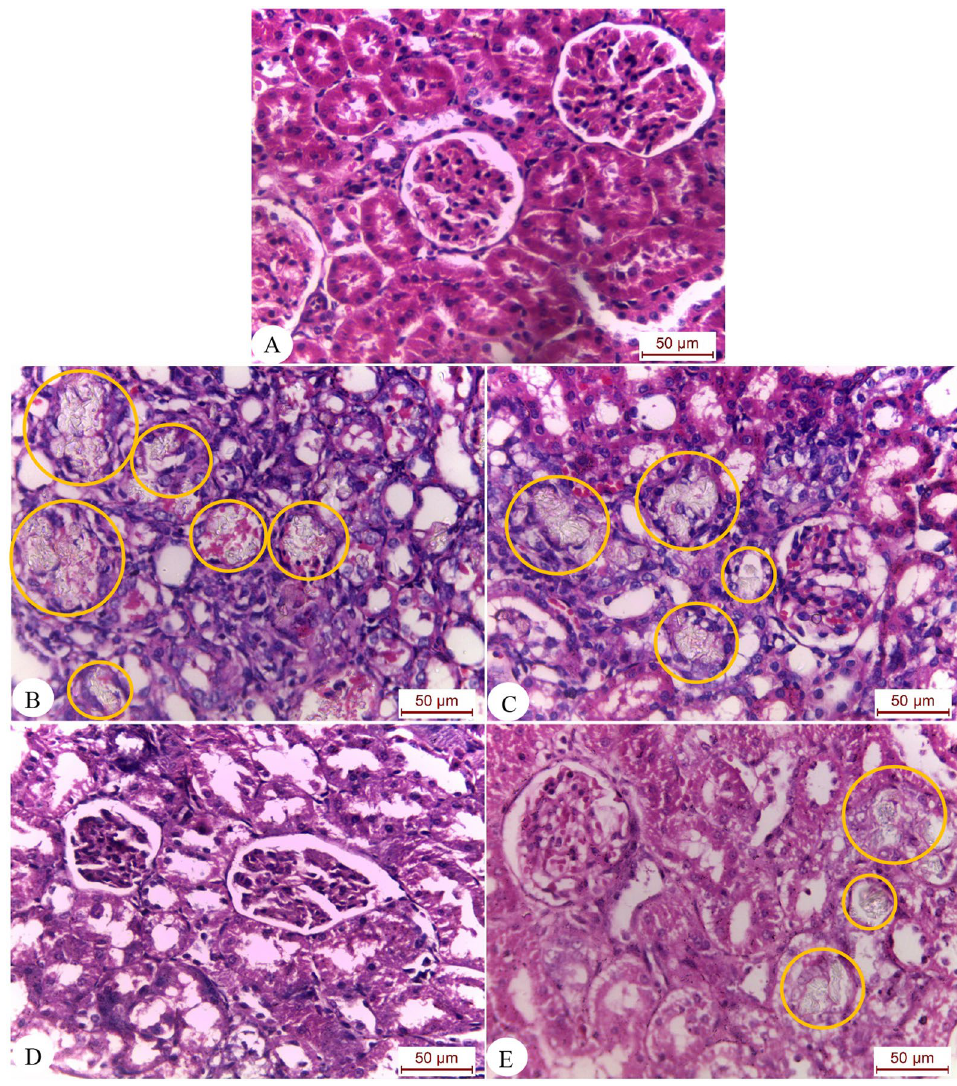
Fig. 6 Photomicrograph of kidney sections of rats in curative regimen (H&E). A Control rats showing normal glomeruli (G) and tubular renal structure. B , C Urolithiatic rats showing multiple crystals deposition (yellow circle). D Urolithiatic rats treated with LACTN (500 mg/kg b.wt) showing less crystal deposits. E Urolithiatic rats treated with cystone (750 mg/kg b.wt) showing more or less drop in crystal deposition